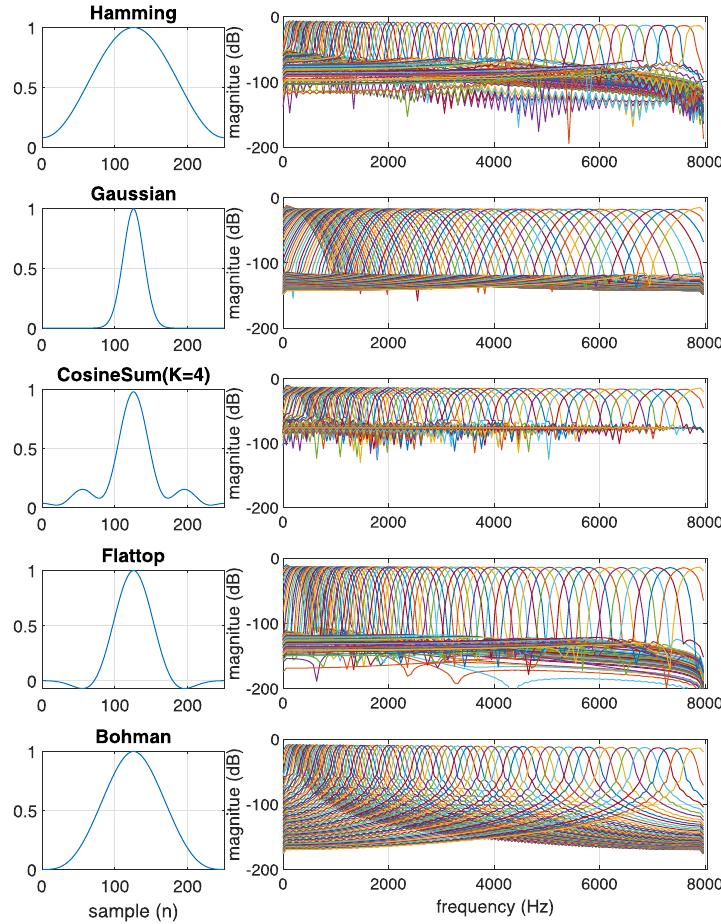
Fig. 3 Frequency response of 80 time-localized Sinc filters using five different window